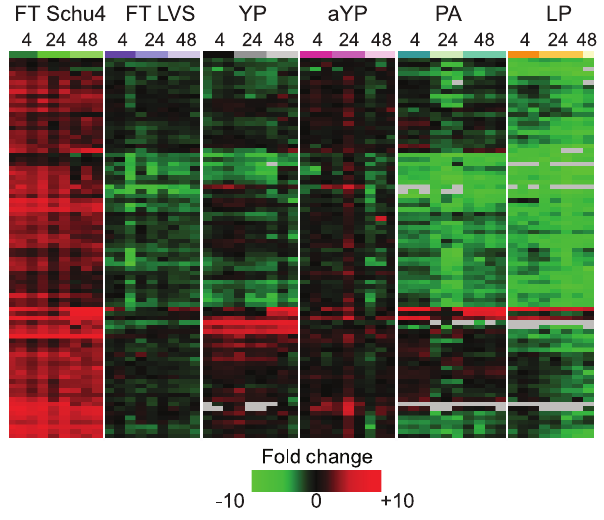
Figure 3. FT SchuS4 induces the expression of a unique subset of inflammatory mediators. Expression profiles of transcripts encoding inflammatory mediators that were regulated (at least 2-fold difference in median expression levels, p-value , 0.01) at four hours post-FT SchuS4 exposure. Each column represents expression data from an individual experiment comparing RNA from lung tissue from an infected animal to pooled RNA from lung tissue from mock-infected animals (n=9). Genes shown in red were up-regulated, genes shown in green were down-regulated and genes in black indicate no change in expression in infected relative to uninfected animals. Grey indicates no data.